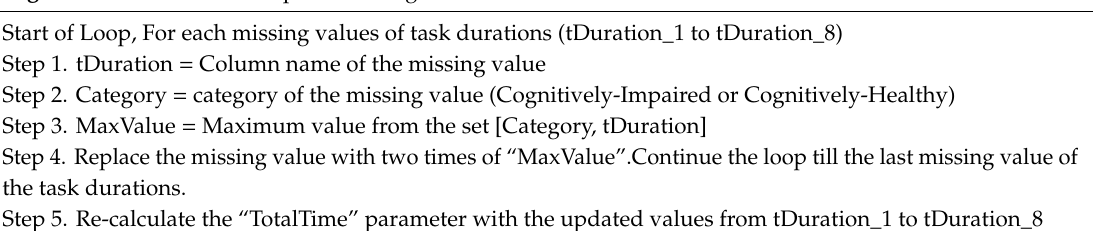
Algorithm 2 Procedure to replace missing